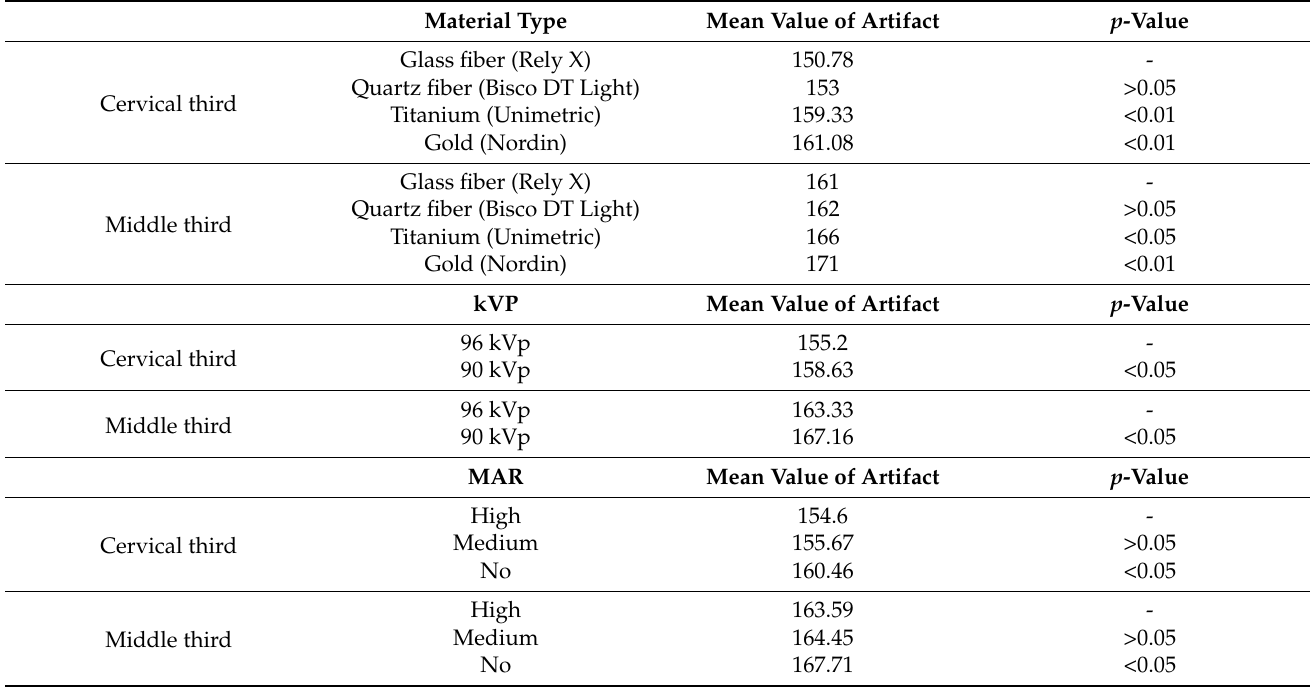
Table 3. Artifact comparison by material type, KVP, MAR, and voxel